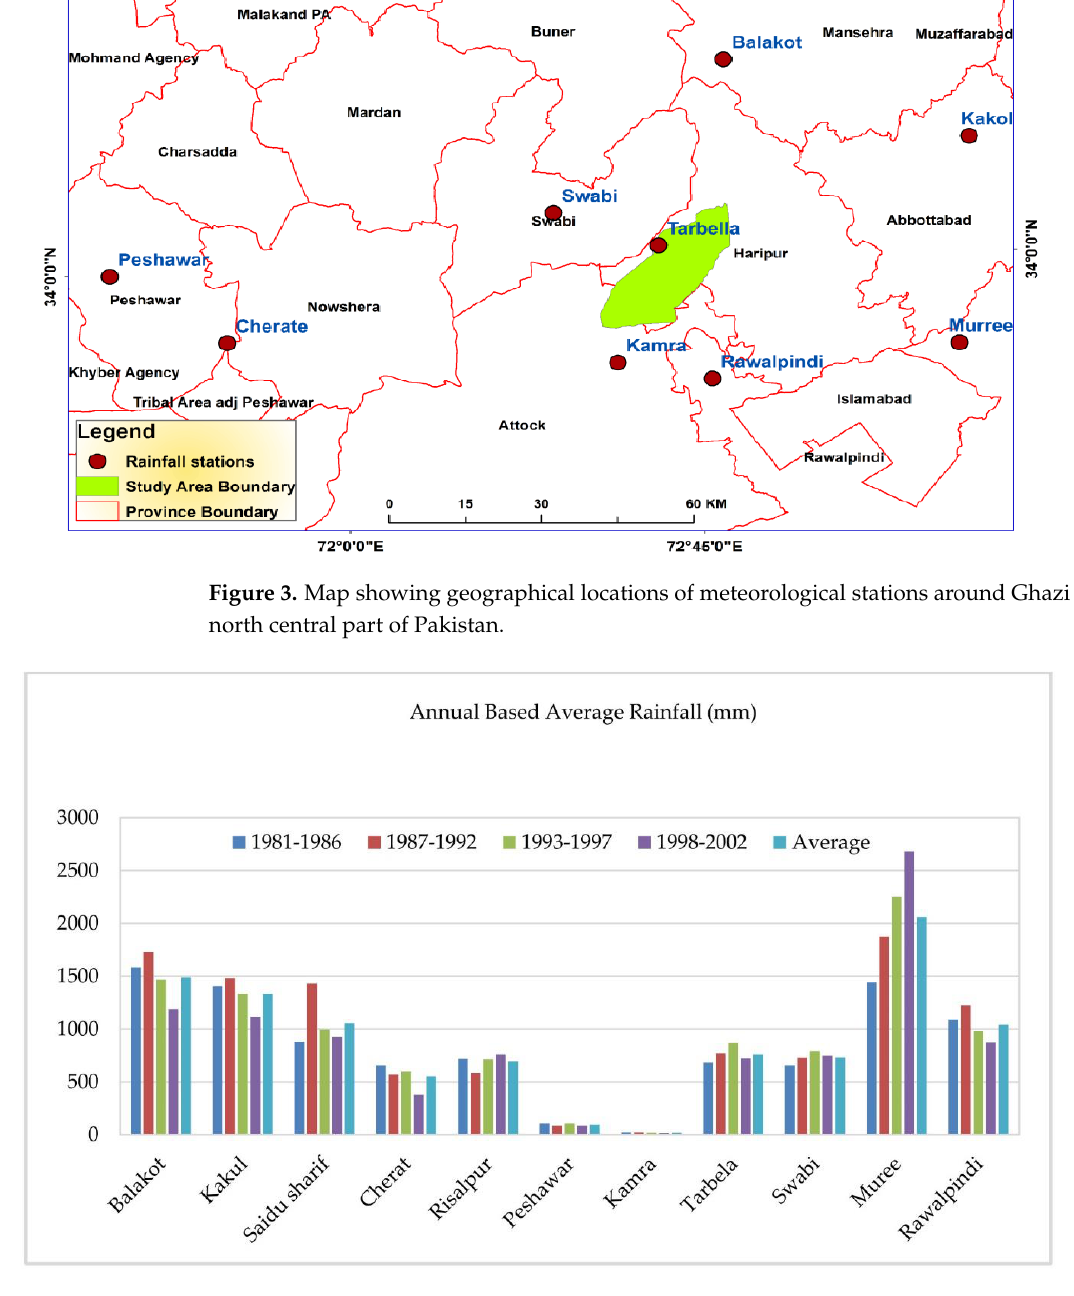
Figure 4. Average annual precipitation data (1981-2002) of different weather stations including Tarbela. Curve number, grid map generation and curve number lookup table